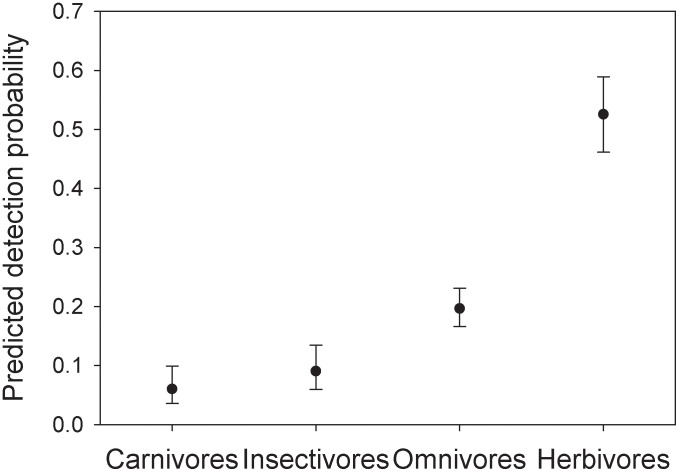
Detection probability by functional guild.Values are from the model averaging of relative species richness of the mammal community in the Udzungwa Mountains of Tanzania. Bars are 95% confidence intervals.